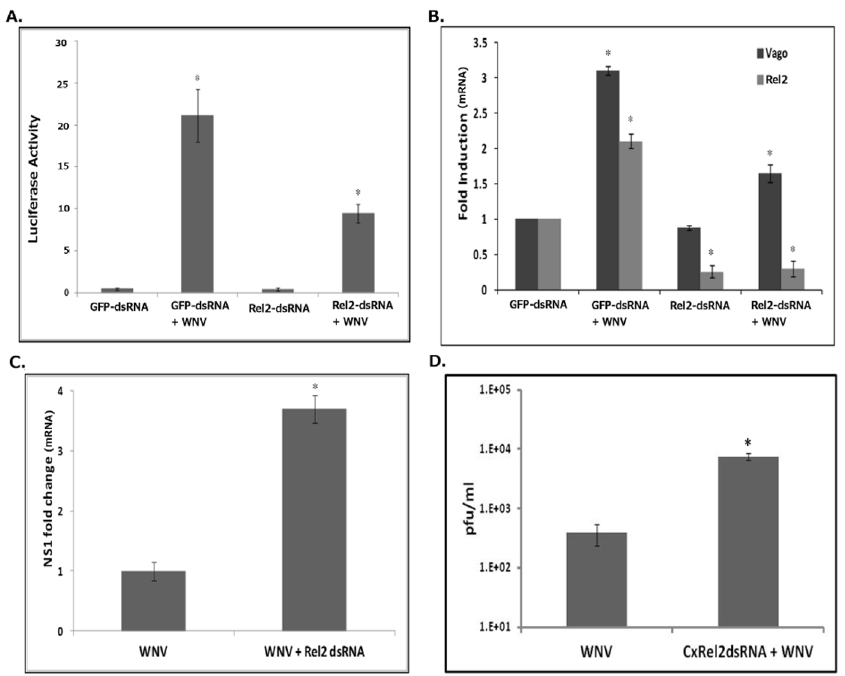
Figure 3. Cx Rel2 is required for activation of WNV-induced Cx Vago. ( A ) Hsu cells were transfected with dsRNA against Rel2 (Rel2-dsRNA) or control dsRNA (GFP-dsRNA) along with plasmid containing the Vago-Luciferase reporter (and firefly luciferase control plasmid). At 24 h post- transfection, the cells were infected with WNV and luciferase activity was measured at 24 hpi. The Renilla luciferase activity values were standardised using firefly luciferase activity values (R/F) and resulting values were plotted as bar graphs. * indicates p , 0.05 compared to GFP-dsRNA. ( B–D ) Hsu cells were transfected with dsRNA against Rel2 (Rel2-dsRNA) or control dsRNA (GFP-dsRNA). At 24 h post-transfection, the cells were infected with WNV and total RNA was collected 48 hpi. ( B ) Real-time RT-qPCR was conducted using primers for Cx Vago, Cx Rel2 and Cx RpL32 (control). * indicates p , 0.05 compared to GFP-dsRNA. ( C ) Real-time RT-qPCR was conducted using primers for WNV-NS1. * indicates p , 0.05 compared with WNV infection. ( D ) Viral titer estimation by plaque assays conducted on the supernatant media from these cells at 48 hpi. Error bars represents standard error from three separate experiments with assays performed in triplicate (Student’s t-test *p , 0.05 compared to GFP-dsRNA).